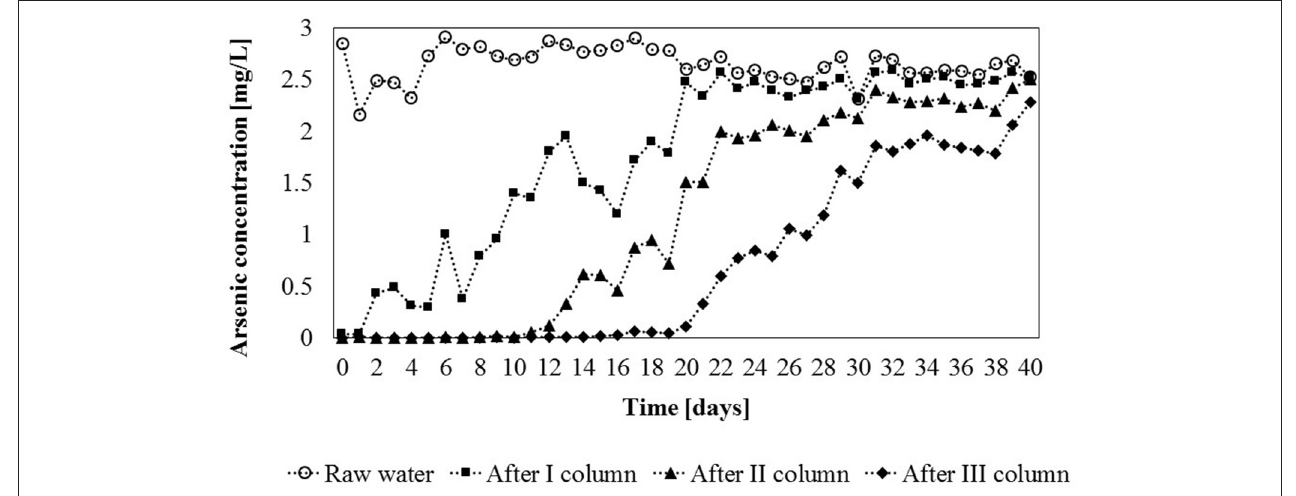
FIGURE 8 | Total arsenic concertration [mg/L] in untreated water and after each column of the installation in constant flow experiments (flow rate = 8 L/h) (measurement deviation 0.6%).